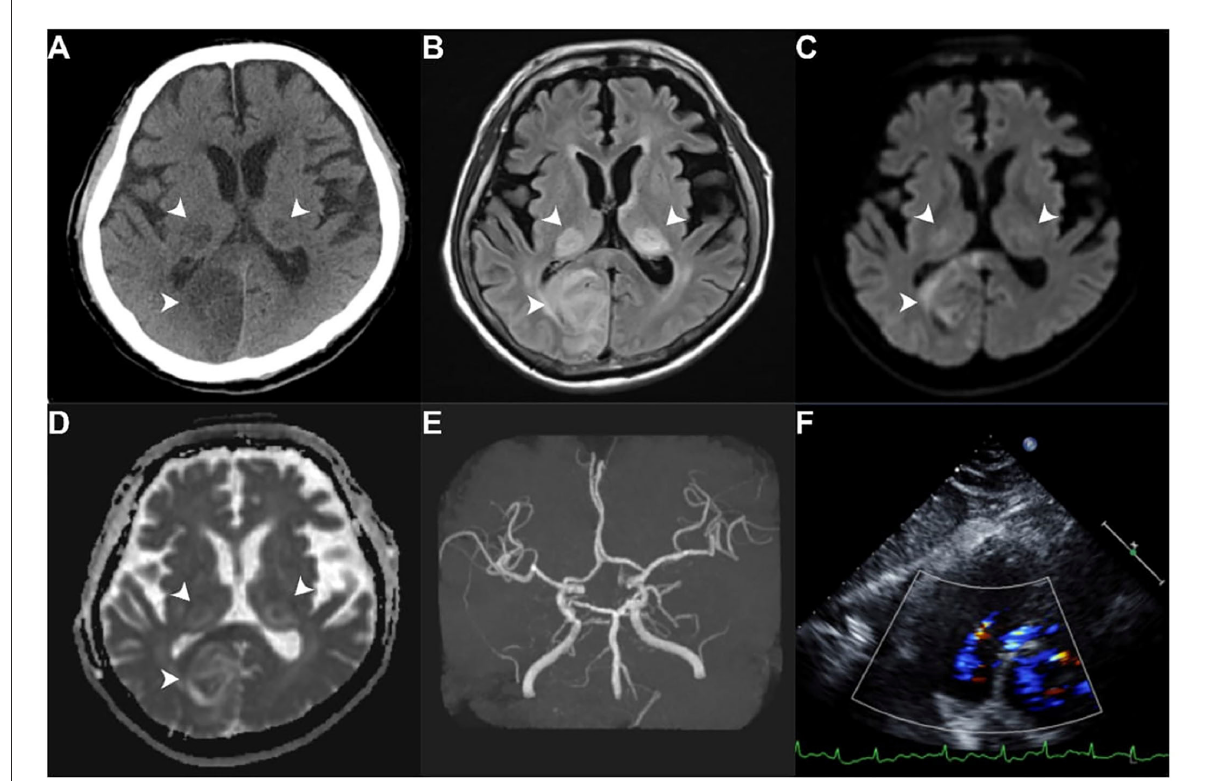
FIGURE1 A stroke patient with atrial fibrillation. A 71-year-old male with a history of atrial fibrillation presented with altered mental status. He was admitted to the neurological ward due to a suspected ischemic stroke event. Head computed tomography without contrast revealed hypodense areas in bilateral thalami and occipital lobes [white arrowhead (A) ]. Head magnetic resonance imaging confirmed acute cerebral infarction [white arrowhead (B–D) ]. Magnetic resonance angiography reported a generalized atherosclerotic change of the bilateral posterior cerebral artery and severe narrowing of the right proximal carotid siphon (E) . Transthoracic echocardiography showed a normal left ventricular ejection fraction of 57% (F) . (A) Head computed tomography without contrast; (B) T2FLAIR magnetic resonance imaging; (C) Diffusion-weighted magnetic resonance imaging; (D) Apparent diffusion coefficient magnetic resonance imaging; (E) Magnetic resonance angiography; (F) Four chamber echocardiographic views of